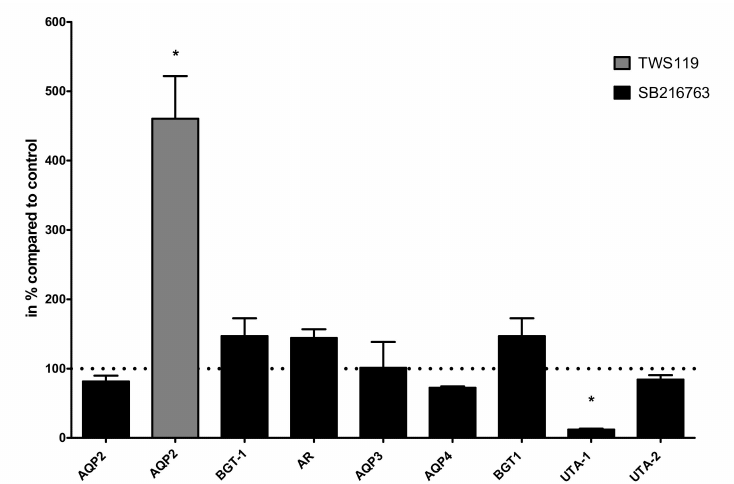
Figure 5. E ff ect of SB216763 and TWS119 on gene expression. IMCD cells were treated with the GSK3 α / β inhibitor SB216763 (10 µ M / 24 h) and the expression of AQP2, AQP3, AQP4, betaine / GABA transporter 1 (BGT-1), aldose reductase (AR), urea transporter 1 (UTA-1), and urea transporter 2 (UTA-2) was compared to untreated cells using real-time PCR. In the same way as cells treated with the GSK3 β inhibitor TWS119 (10 µ M / 24 h), the expression of AQP2 was compared to untreated cells. One-way ANOVA analysis with Tukey post-test to compare the AQP2 columns, * indicates statistically significant di ff erences compared to untreated cells ( p ≤ 0.05); n = 3.